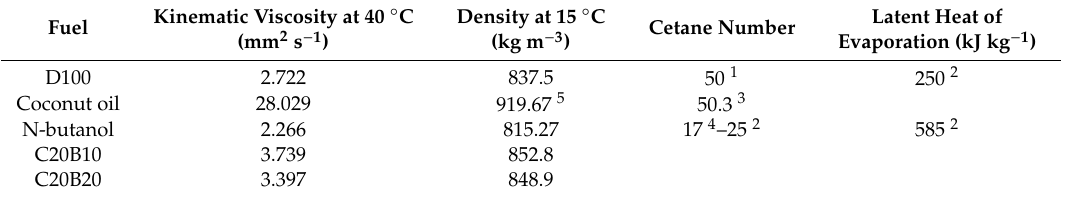
Table 2. Basic fuel properties of tested fuel blends and their